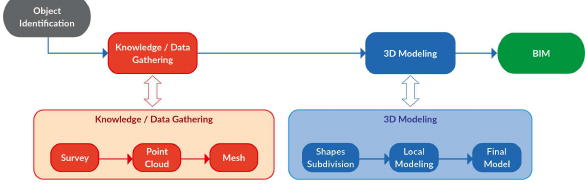
Figure 1. Classic workflow for H-BIM with external modeling tools